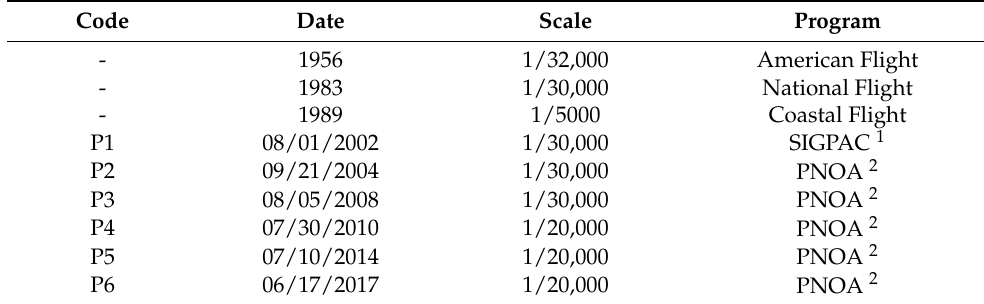
Table 1. Date of the aerial images and orthophotographs used.